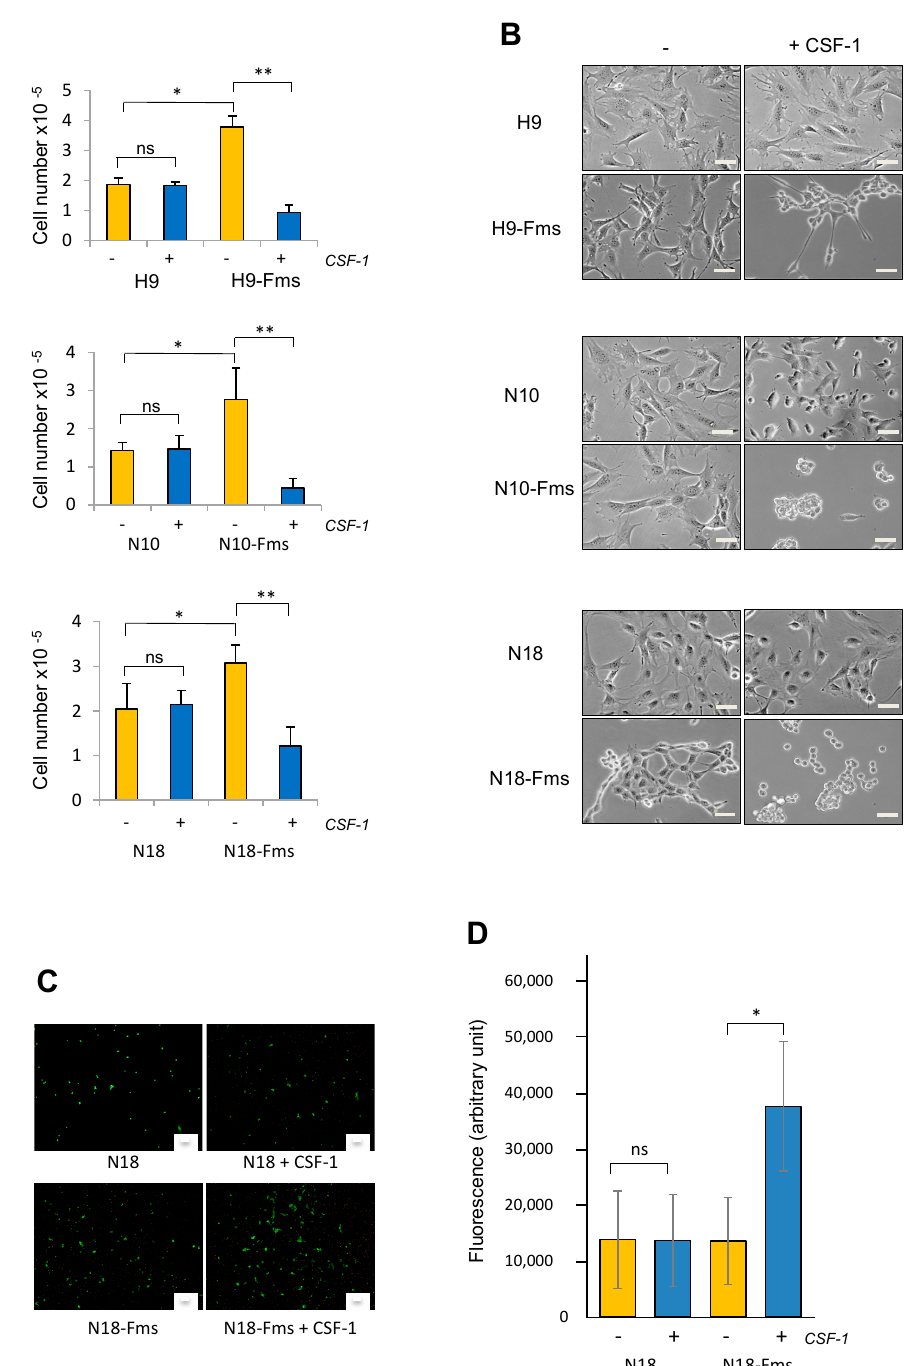
Figure 2. Biological effects of CSF-1R signaling on prostate cancer cells. ( A , B ) Effects on cell growth in 2D culture: 2 × 10 4 prostate cells were seeded in the presence (+) or absence (-) of CSF-1 for 3 days and enumerated. ( B ) Representative photographs (n = 3) of each cell populations after 3 days of culture in the presence (+) or absence (-) of CSF-1, scale bars, 10 µ m. ( C , D ) Effects on cell invasion. Invasive capacities of parental N18 prostate cells and CSF-1R-expressing N18 prostate cells (N18-Fms) were determined by transwell assay in the presence (+) or absence (-) of CSF-1. ( C ) Representative photographs (n = 3) of each cell populations after 5 days of culture in the presence (+) or absence (-) of CSF-1; cells were stained with calcein AM. Scale bars, 100 µ m. ( D ) Fluorescence values are expressed as mean ± s.d of 3 independent experiments. ns = not significant, * p < 0.05, ** p < 0.01.